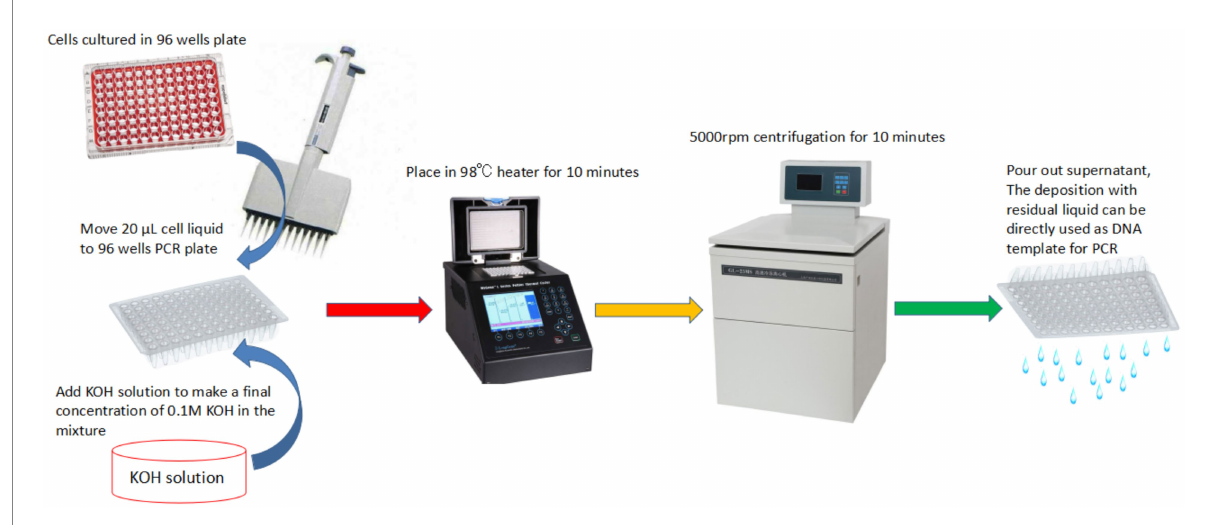
FIGURE 3 The PBC technique in a high throughput format for a large number of